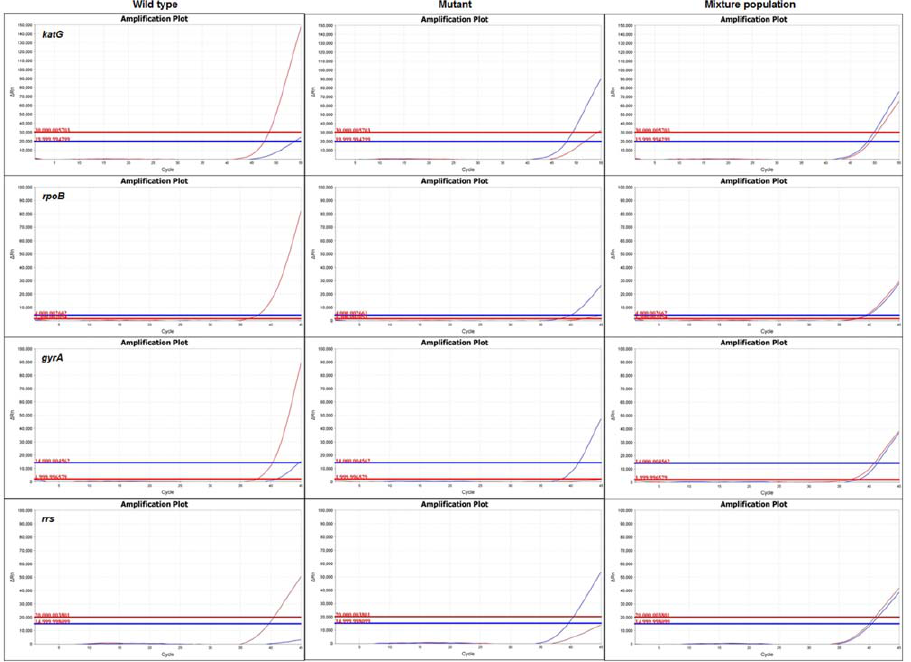
Figure 5. Digital PCR. The DNA of each H37Rv:XDR-TB mixture was diluted 1:10000 and subjected to real-time PCR for each gene with both probes in 384 well plates. This figure shows representative 10:1 ( katG, gyrA, rrs ) or 100:1 ( rpoB ) mixtures. Individual wells revealed detection with the wild- type probe (red traces), mutant probe (blue traces), both, or neither. qPCR thresholds were set per Figure 1 (red and blue horizontal lines for wild- type and mutant fluorophores, respectively). Cycling continued for 55 cycles (for katG ) due to dilute DNA